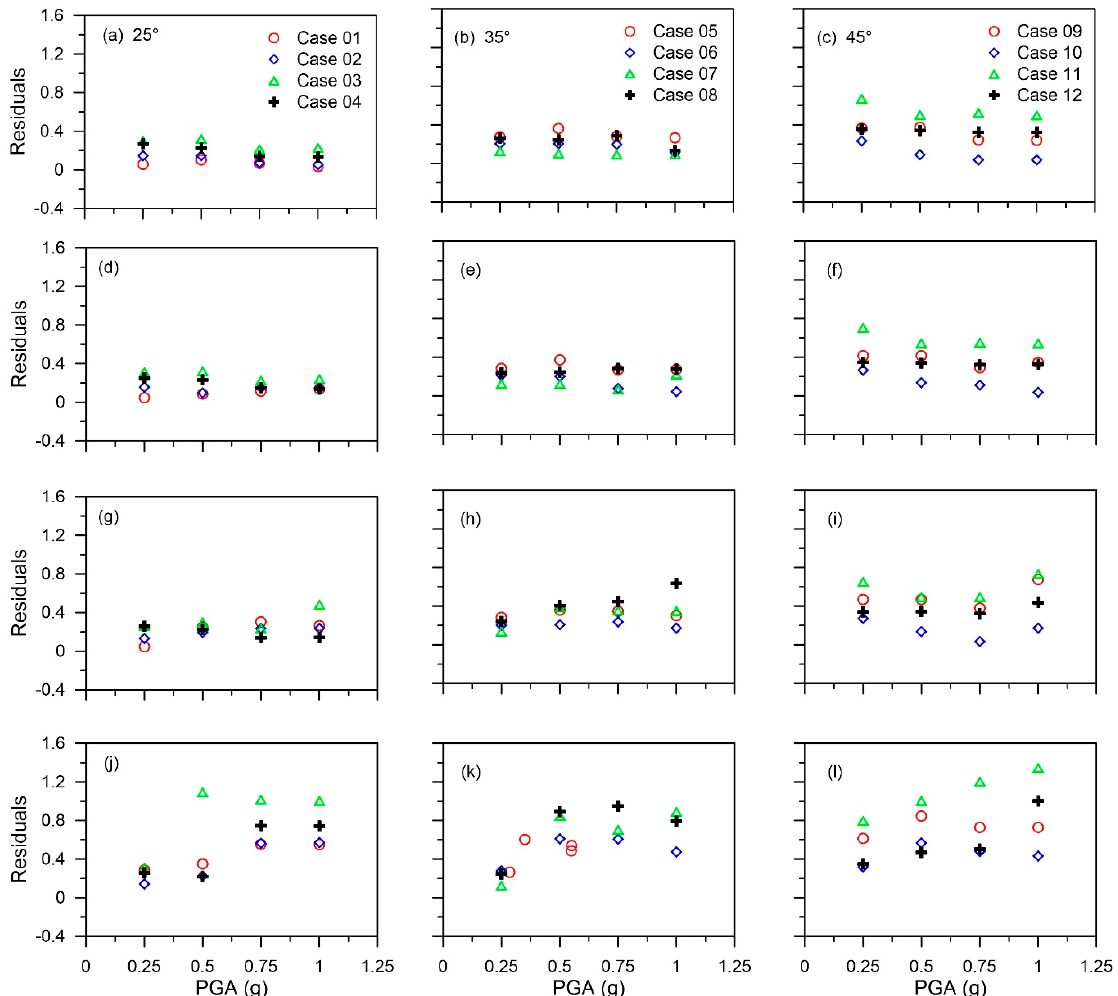
Figure 9. Residuals of failure surface: ( a – c ) Whittier Narrows ( d – f ) Northridge ( g – i ) Ofunato ( j – l ) Kobe.